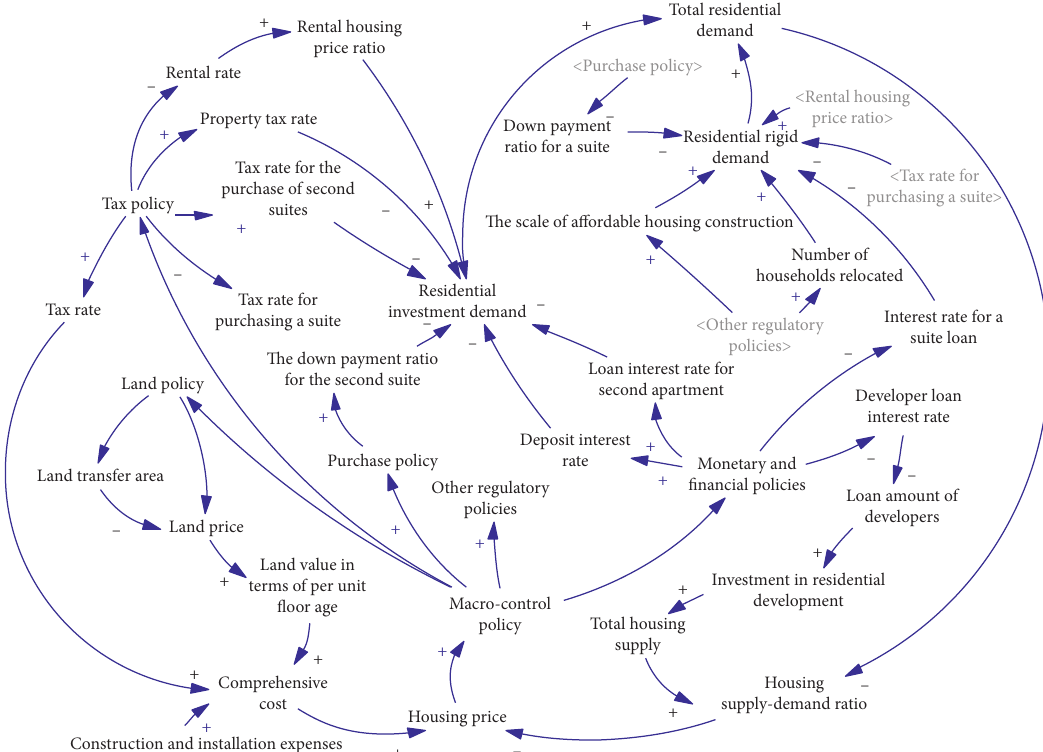
Figure 8: Causality diagram of macro-control policy subsystem.